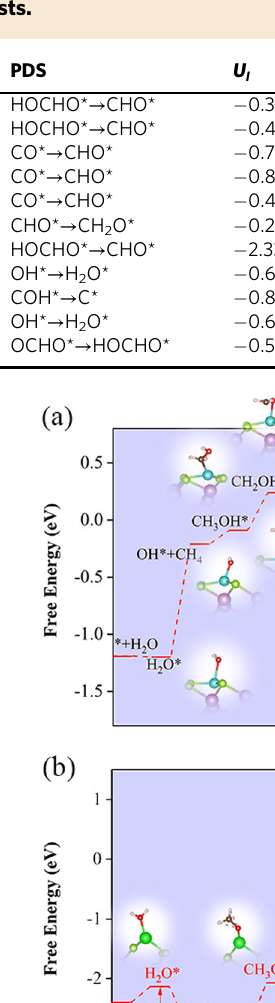
Table 2 Potential determining steps (PDS), limiting potentials ( U l , V vs RHE), and fi nal product of CO 2 RR with